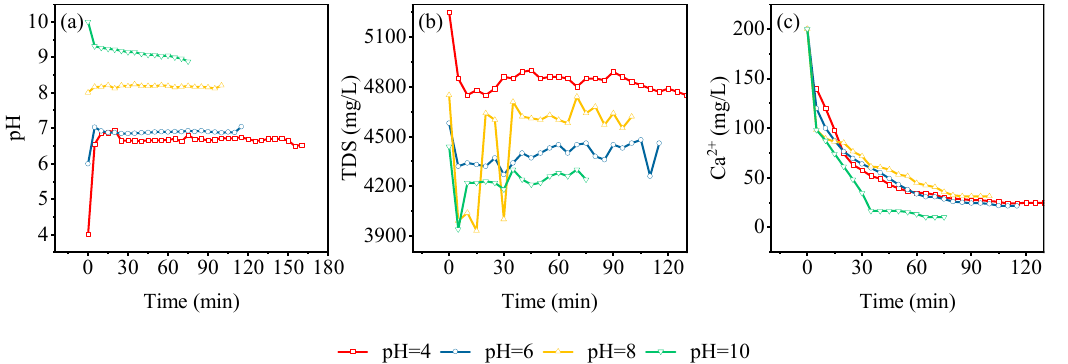
Figure 11. Solution characteristics of muddy siltstone subjected to dynamic leaching by mine water at different pH values: ( a ) pH value; ( b ) TDS concentration; ( c ) Ca 2+ concentration.